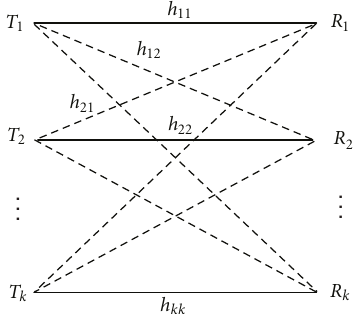
Figure 1: K -user N -carriers interference channel under study.